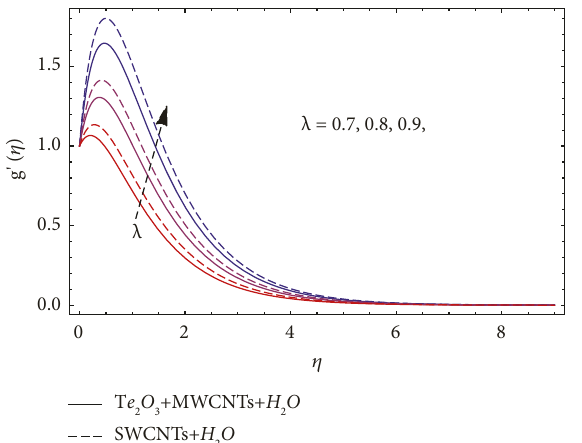
Figure 8: Influence of mixed convection parameter on velocity profile in y direction.